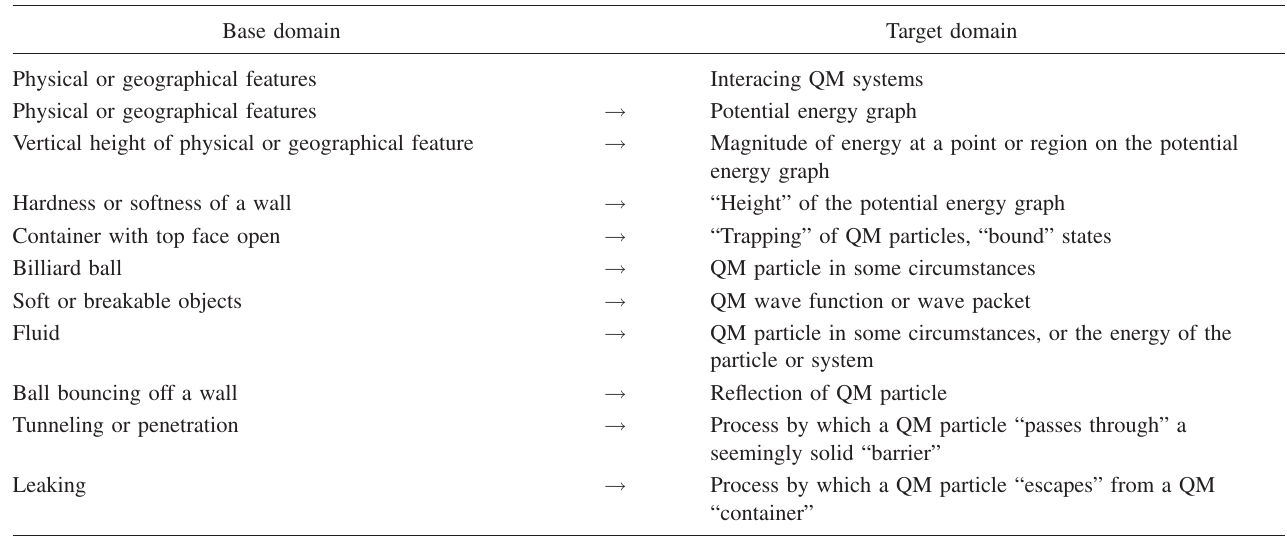
TABLE V. Summary of the metaphorical mapping between the base domain of physical or geographical features and the target domain of interacting QM